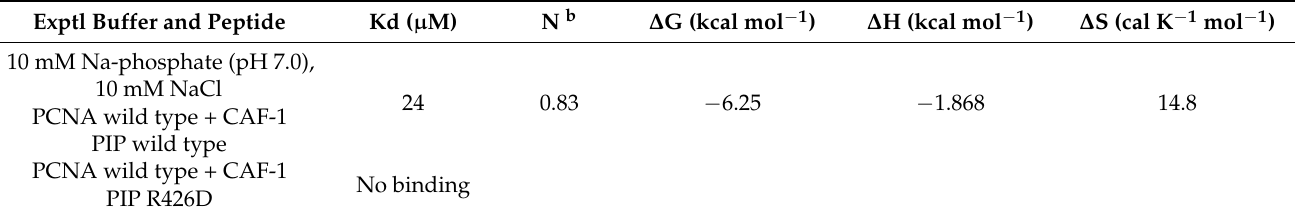
Table 2. Thermodynamic parameters of PCNA binding to PIP a